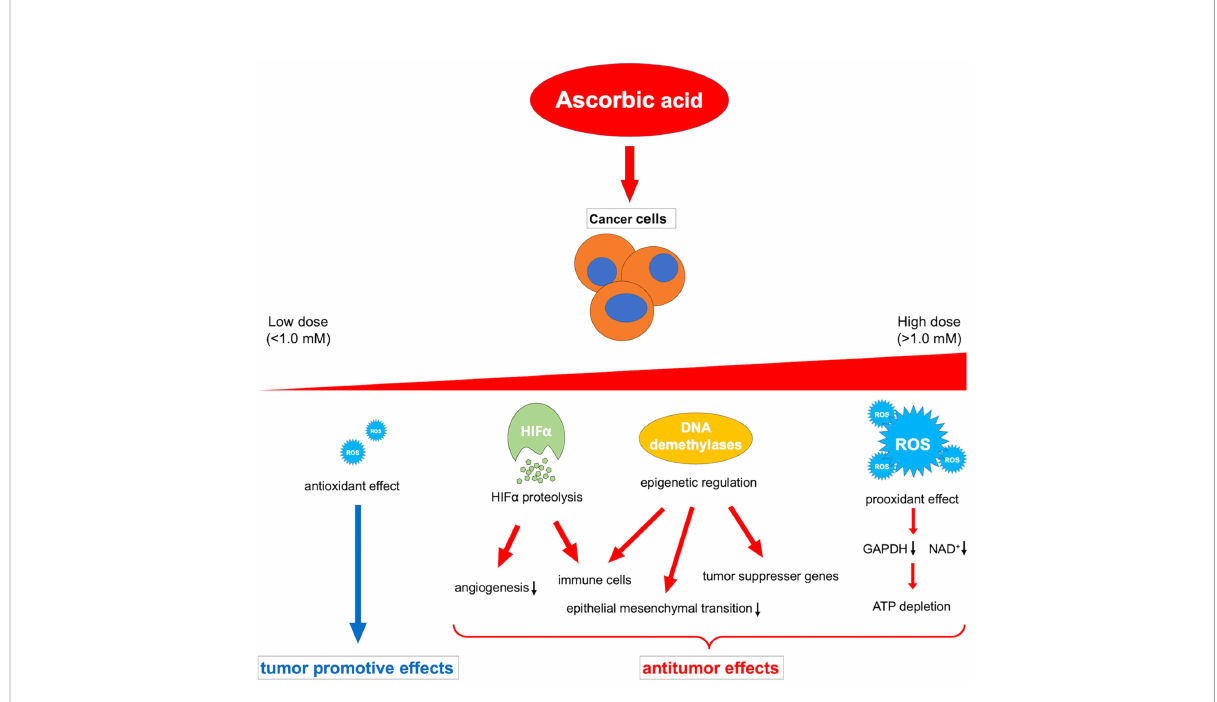
FIGURE 2 Overview of the various dose-dependent effects of ascorbic acid on cancer. ROS, reactive oxygen species; HIF a , hypoxia-inducible factor- alpha; GAPDH, glyceraldehyde 3-phosphate dehydrogenase; NAD + , nicotinamide adenine